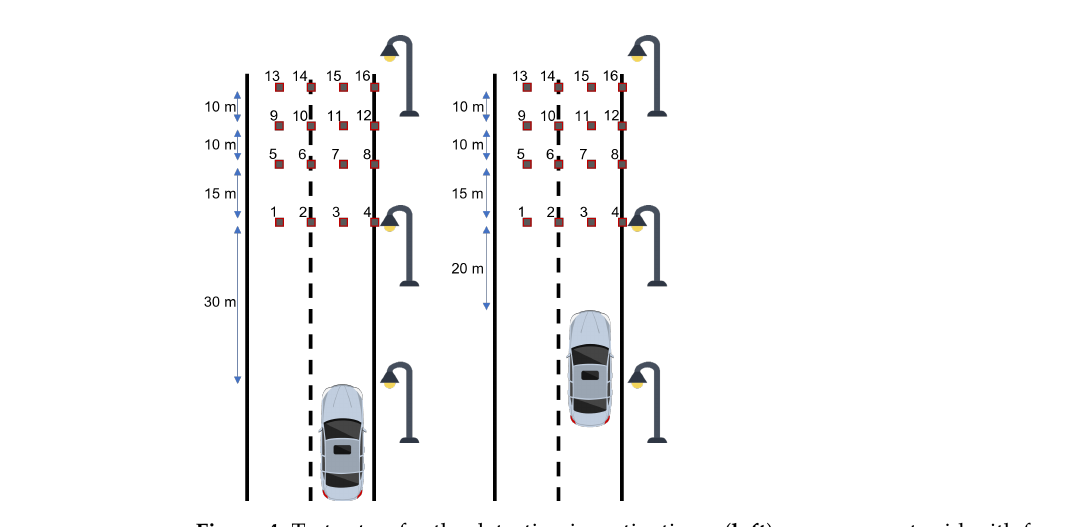
Figure 4. Test setup for the detection investigations: ( left ) measurement grid with four flat targets each at distances of 30m, 45m, 55m, and 65m; ( right ) measurement grid with four flat targets each at distances of 20m, 35m, 45m, and 55m. The numbers on the flat targets indicate the internal position